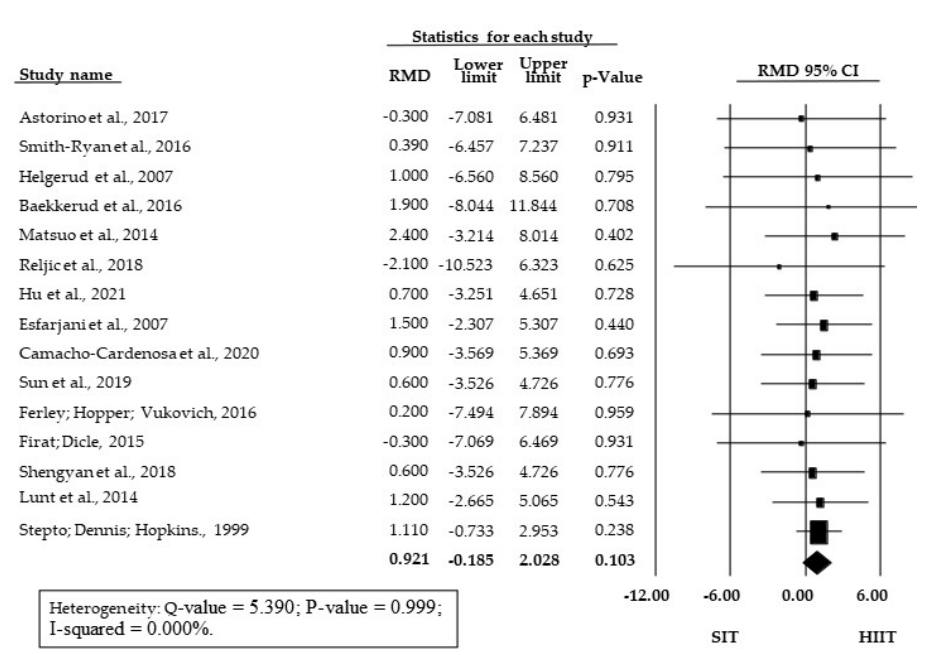
Figure 3. Forest Plot of raw mean differences (RMD in mL·kg − 1 ·min − 1 ) between HIIT and SIT; 95% CI, 95% confidence interval; SIT, sprint interval training; HIIT, high-intensity interval training. Since the analyses were significant homogeneous and considerably consistent across studies for both the outcomes measured ( p = 0.999 for SMD and p = 1.000 for RMD and I 2 = 0 for both), fixed effects were assumed for both analyses. There was no significant bias of publication ( p = 0.828), so there was no asymmetry in the funnel plot (Figure 4).